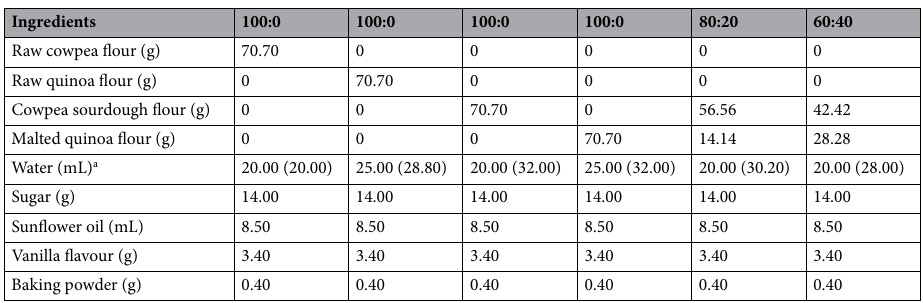
Table 1. Whole-grain and multigrain dough formulations used to prepare traditional and 3D-printed biscuits. a Distilled water levels (mL) in parenthesis were used to prepare the 3D-printed